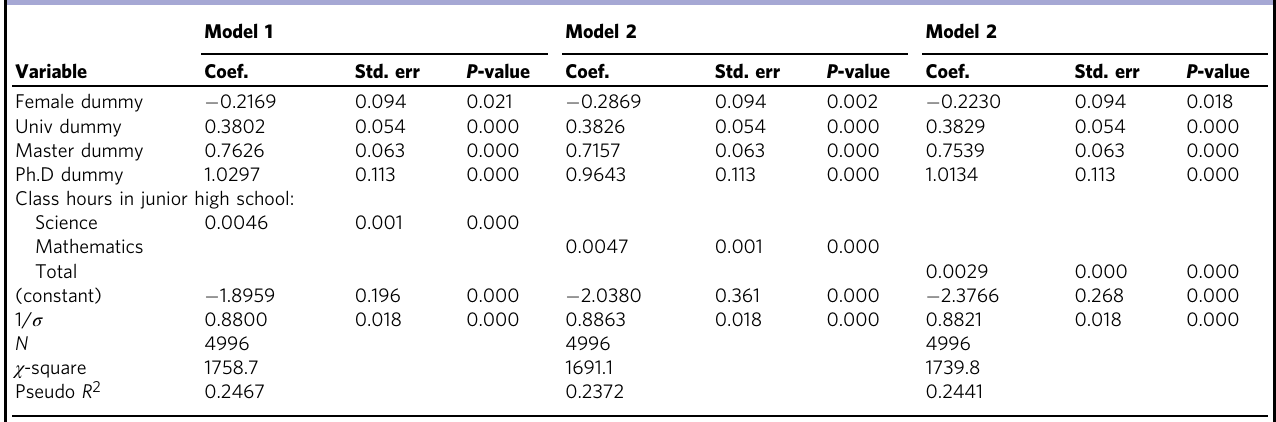
Table 1 Analysis results: number of patent applications per working